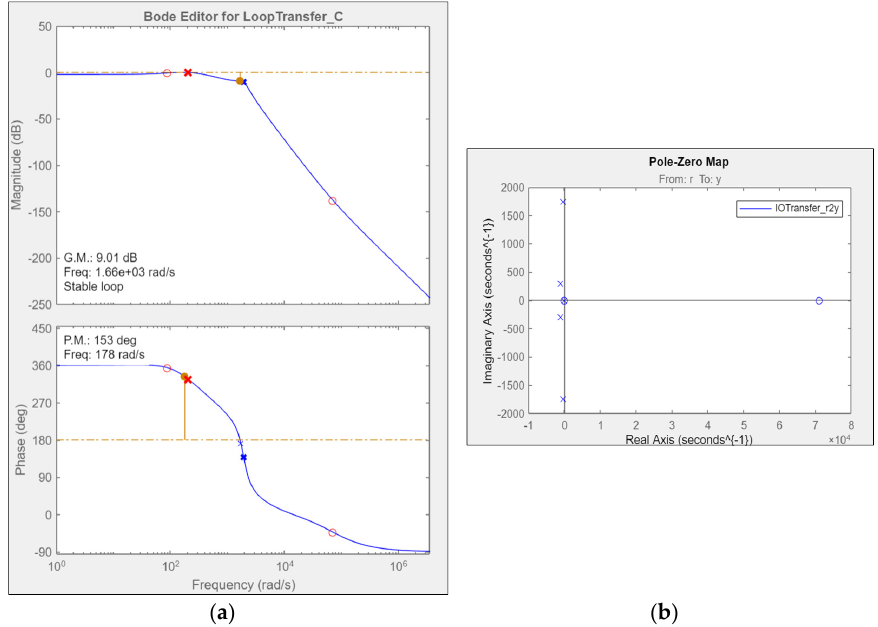
Figure 18. Control loops during the PV to grid inversion: k p = 2.5 and k r = 5. ( a ) Bode plot. ( b ) Pole-zero map.